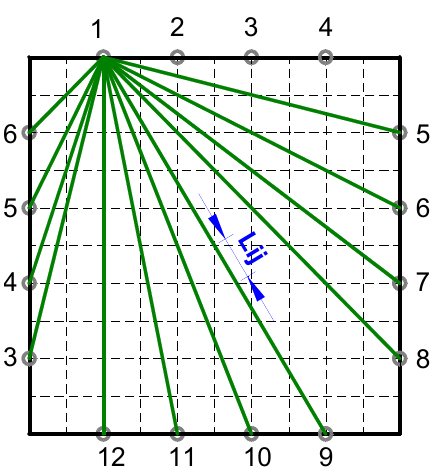
Figure 2. The illustration of the grids and paths in the specimen.